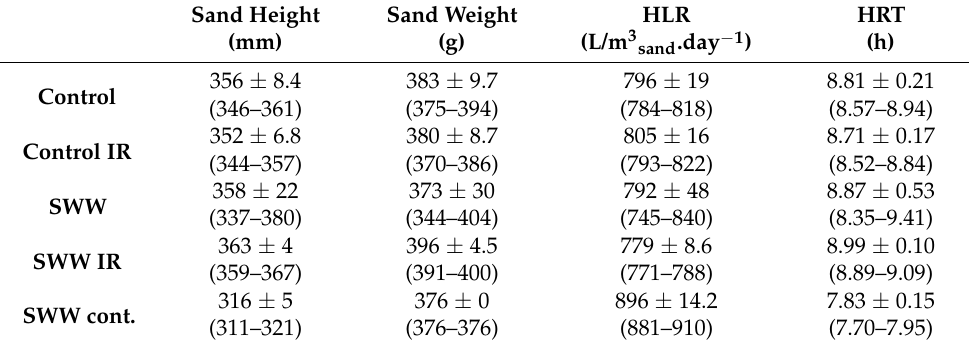
Table 2. Measured operational parameters (average ± SD and range, n = 3).